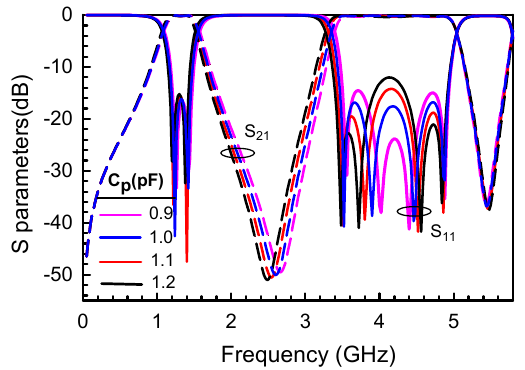
Figure 14. Effect of varying C p on the frequency response of TBFSLR#1.